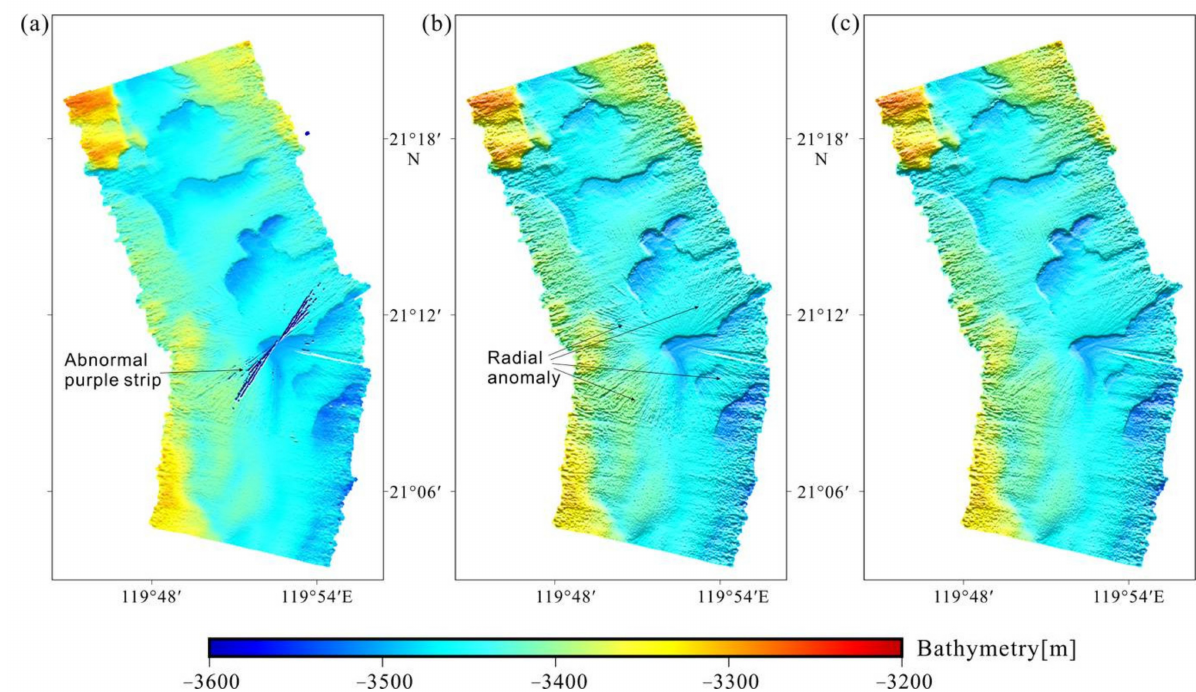
Figure 5. Processing of the radial anomalies in the multi-beam bathymetry data. ( a ) The raw multi-beam bathymetry data with purple linear anomalies and radial anomalies; ( b ) the purple linear anomalies processed by swath filtering; ( c ) the final multi-beam bathymetry data after removing the radial anomalies by surface